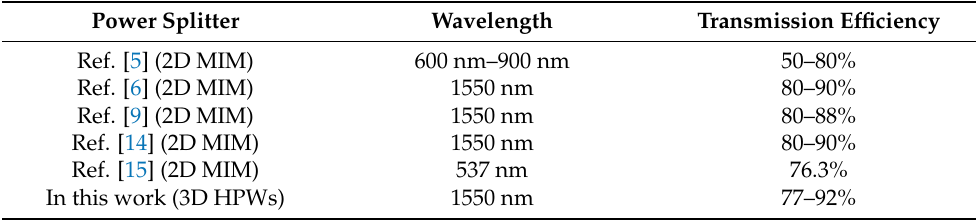
Table 1. The comparison of various power